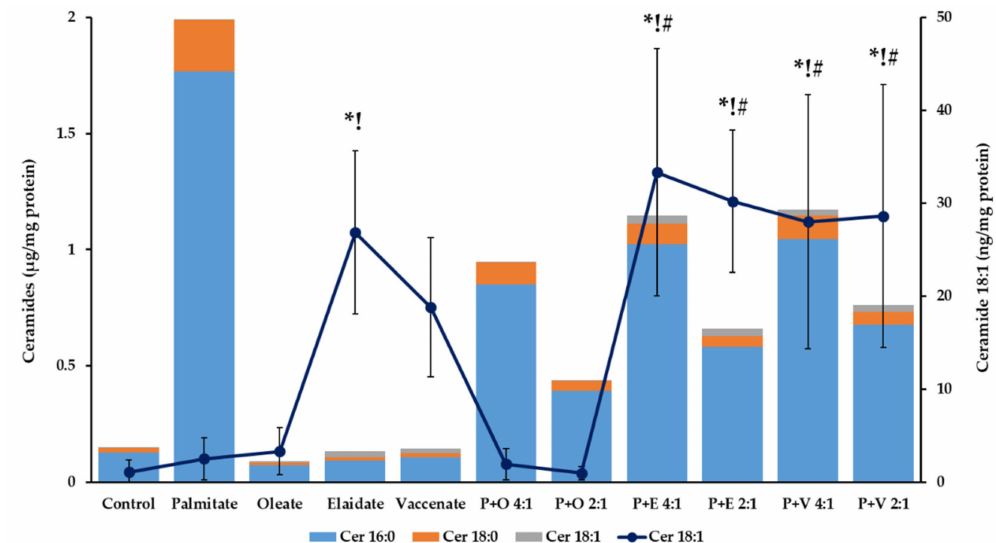
Figure 7. Ceramide content of hepatoma cells in lipotoxicity. Cells were treated with BSA-conjugated palmitate, oleate, elaidate or vaccenate (800 µ M) or with palmitate (800 µ M) and oleate, elaidate or vaccenate at a 4:1 or 2:1 molar ratio (200 or 400 µ M) at 70–80% confluence for 8 h. The amount of three relevant ceramides was measured by LC-MS/MS. Data were normalized to the total protein content of the samples and are shown as mean values of at least four independent experiments (see the mean and S.D. values in Table S8). Ceramide 18:1 contents are also shown separately (line, right axis) as mean values ± S.D.; n ≥ 3; statistically significant differences: * p < 0.05 vs. BSA treated control; ! p < 0.05 vs. palmitate treated samples; # p < 0.05 vs. palmitate and oleate treated cells